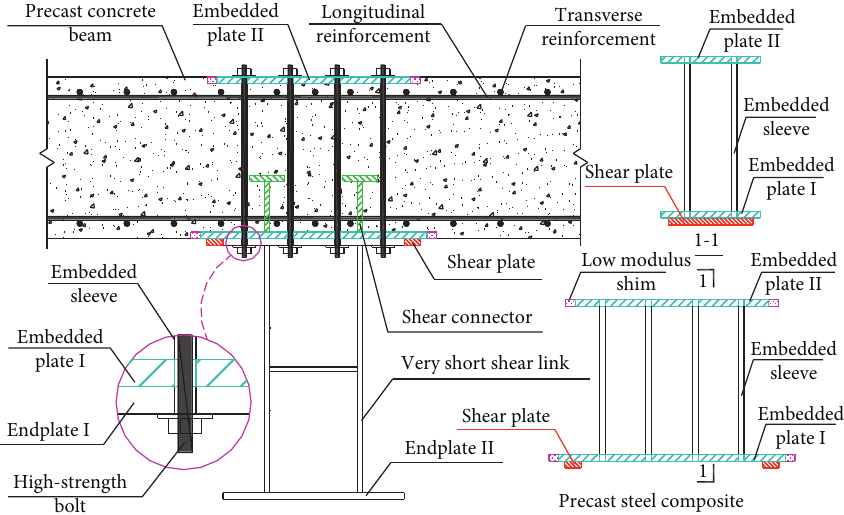
Figure 2: PCB-SLCC with the moment and shear force separate